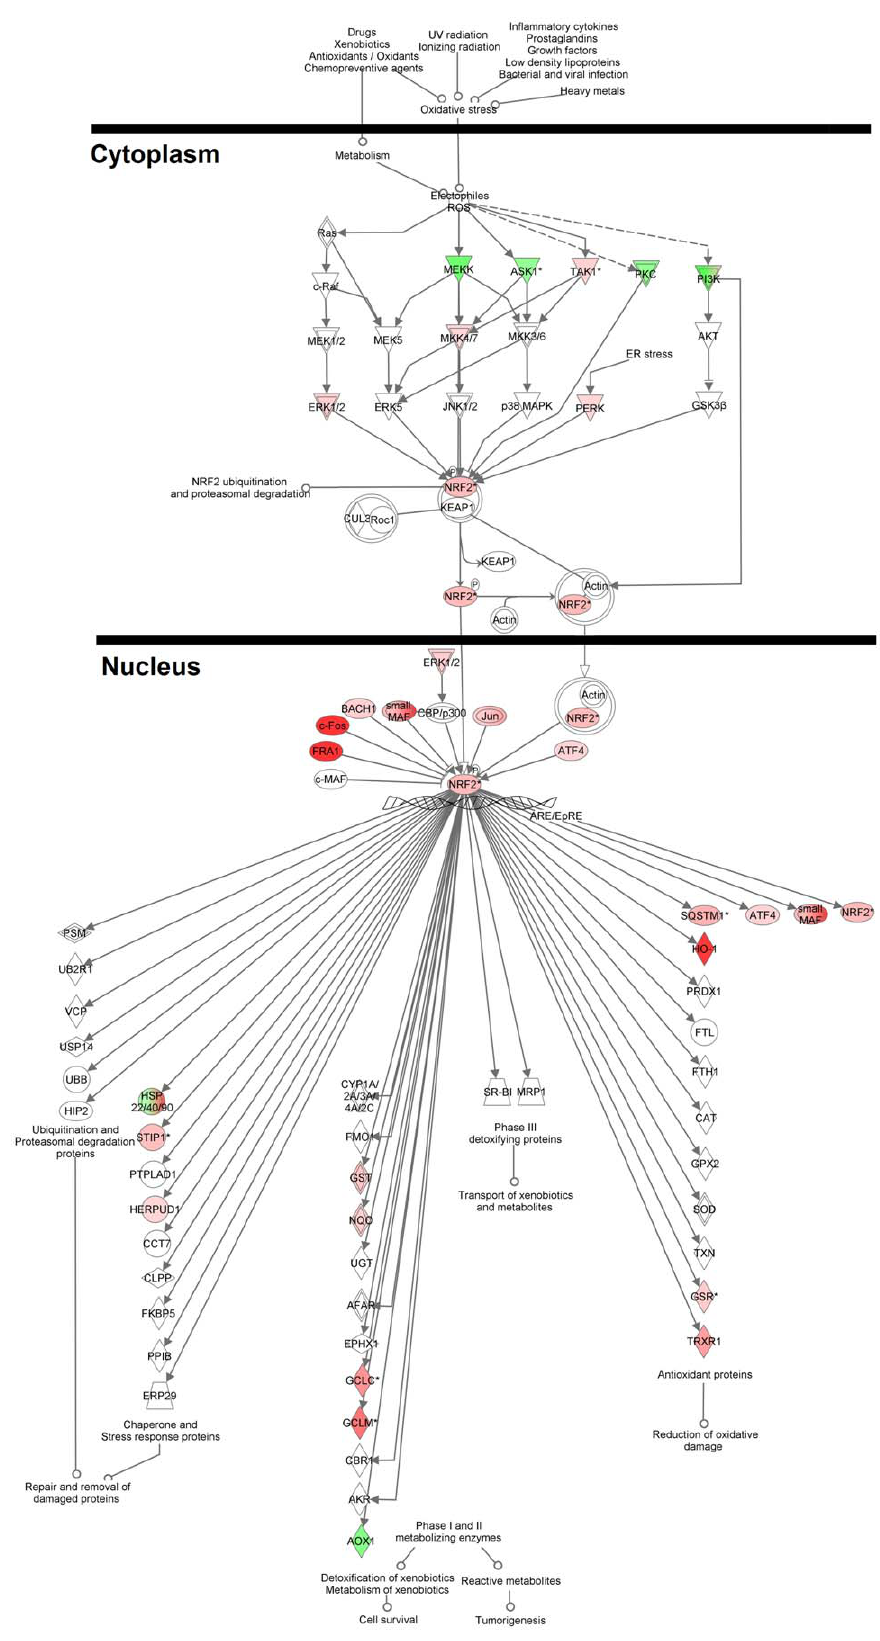
Figure 3. The Nrf2-mediated oxidative stress response pathway in IPA database. The red color and green color indicate the up- and down- regulated genes after treatment with high-concentration of SWT in this pathway, respectively. doi:10.1371/journal.pone.0018278.g003 PLoS ONE |